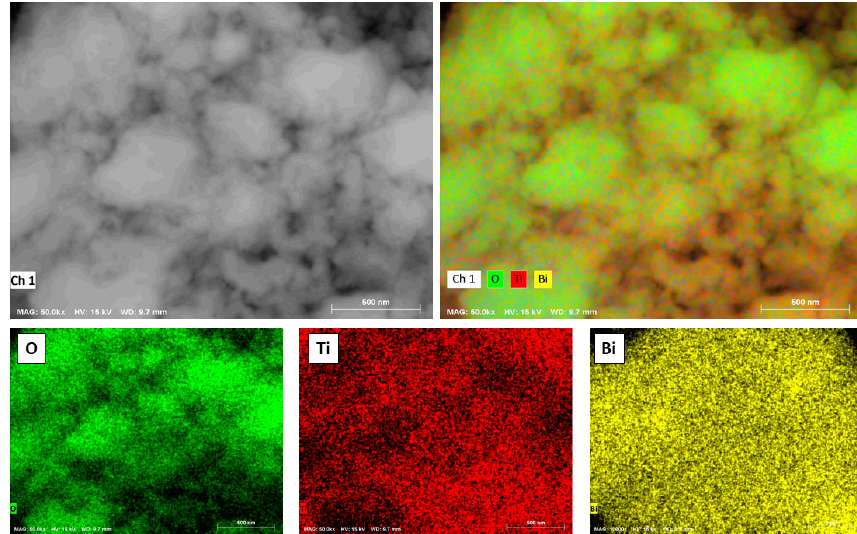
Figure 4. Elemental mapping of Ti, Bi, and O in the TiO 2 Bi 3% sample.